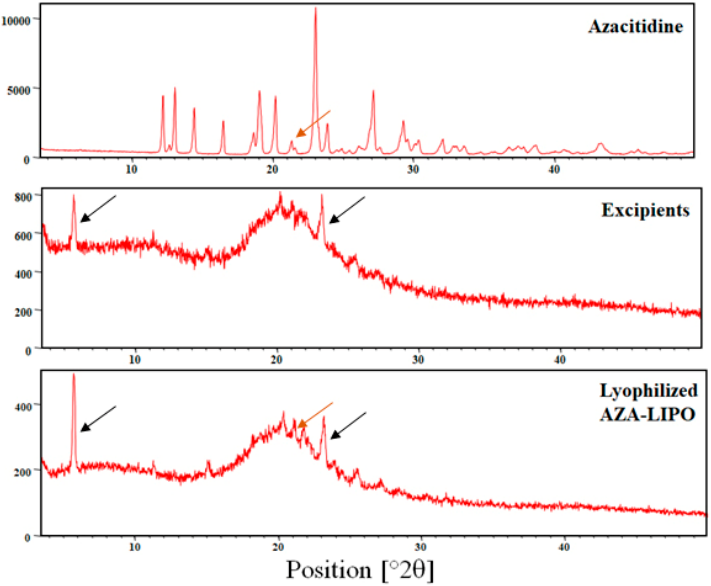
Figure 7. XRD of AZA, excipients and AZA-LIPO formulation. 3.9.